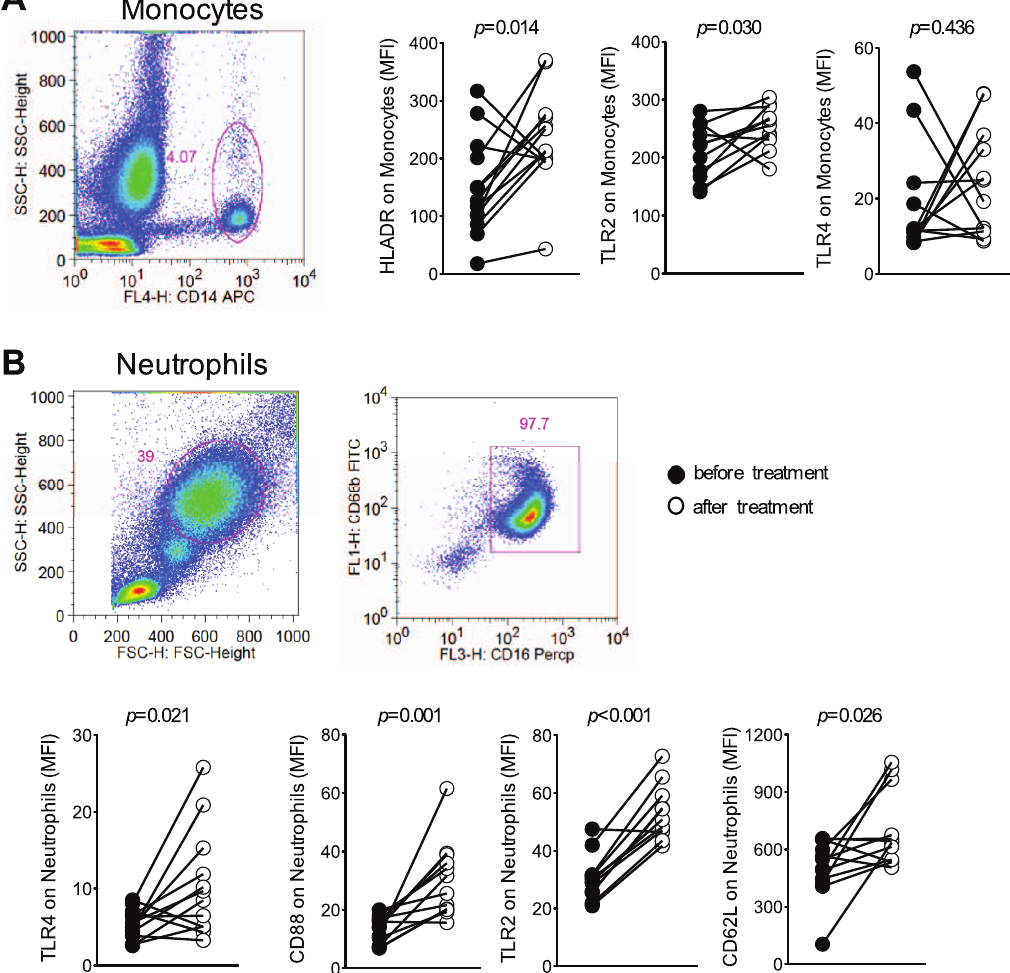
Figure 2. Systemic activation of monocytes and neutrophils during P.vivax malaria. Mean fluorescence intensity (MFI) of HLA-DR, TLR2 and TLR4 was evaluated on monocytes (A) and CD62L, CD88, TLR2 and TLR4 on neutrophils (B) in whole blood from P. vivax- infected subjects (n=12), before (closed circles) and 30–45 days after treatment (open circles). Representative density plots showing the gate strategy for monocytes CD14 + (A) and neutrophils CD66b + CD16 + (B) are shown. Significant differences are indicated with p -values using Wilcoxon signed rank test when the data failed the normality test.